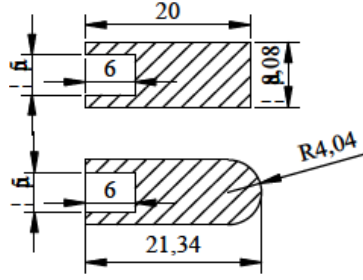
Figure 3: Dimensions of projectiles